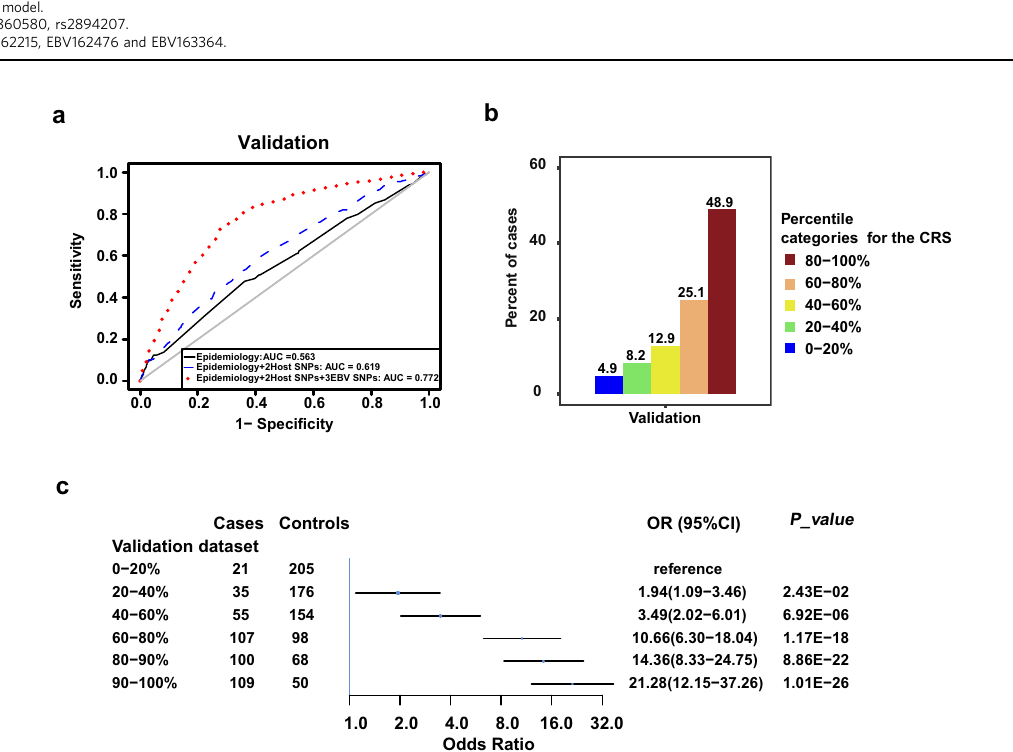
Fig. 2 NPC risk strati fi ed by comprehensive risk score (CRS). a Receiver operating characteristic (ROC) curve analysis of the validation dataset. The area under the ROC curve (AUC) for each model is indicated. b Distribution of patients in the validation dataset strati fi ed into fi ve categories, 0 – 20%, 20 – 40%, 40 – 60%, 60 – 80%, and 80 – 100%, according to the CRS percentile among controls in the training dataset. c Association between the CRS and NPC risk in the validation dataset (Cases: n = 427, Controls: n = 751). The validation dataset was strati fi ed into categories (lower four quintiles and top two deciles) according to the CRS percentile among controls in the training dataset, and participants in the bottom quintile of CRS served as the reference group. The odds ratio (OR) of developing NPC was estimated using logistic regression analysis with each group included as a categorical variable. The blue squares represent the odds ratios of each category, and the error bars represent the 95% con fi dence intervals. CI, con fi dence interval. Source data of ( b ) are provided in the Source Data fi